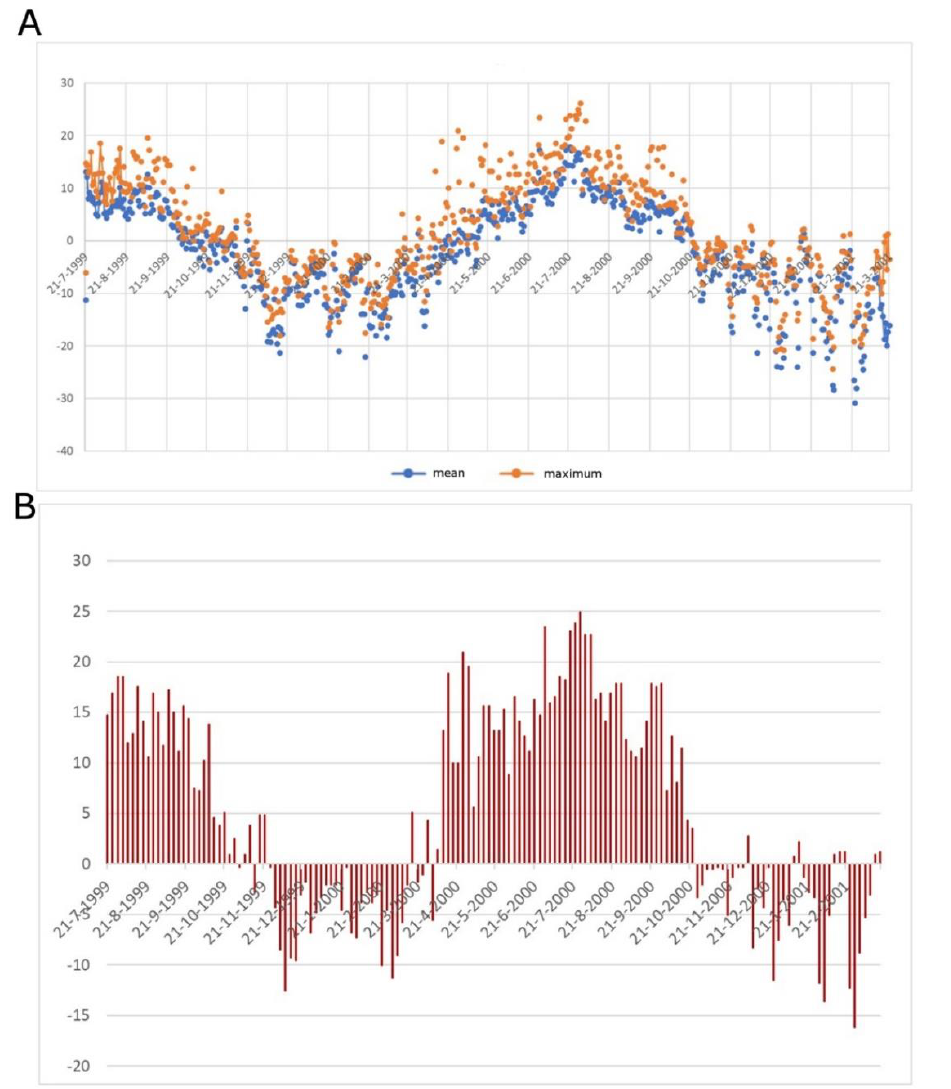
(Figure 5): mean annual -1.4 °C, mean July 12.2 °C,